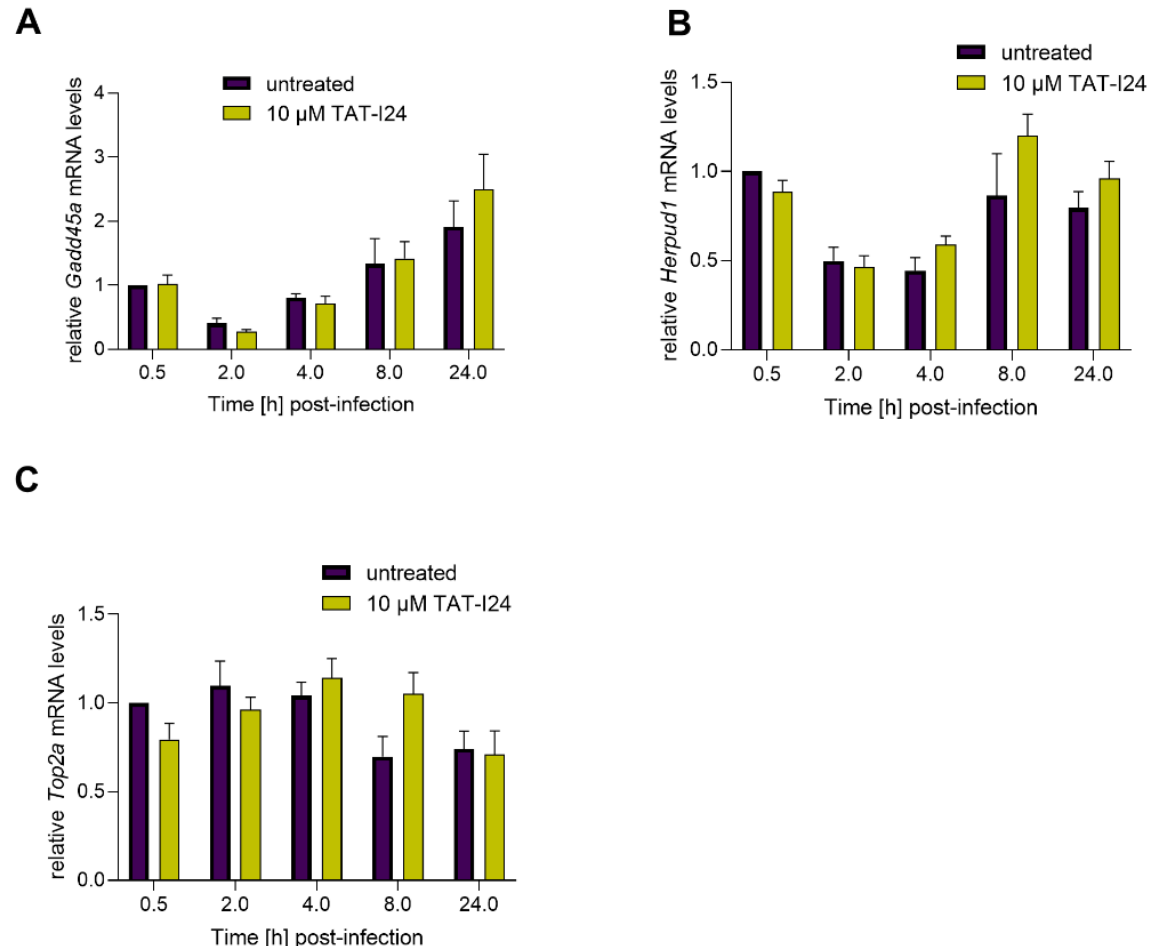
Figure 4. Levels of host-cell transcripts relative to the housekeeping gene Gapdh ( A , Gadd45a ; B , Herpud1 ; C , Top2a ) in NIH/3T3 cells infected with MCMV (MOI 1) in the presence or absence of 10 µ M TAT-I24. Fold change in transcripts levels (mean ± standard error of the mean) from four independent experiments is